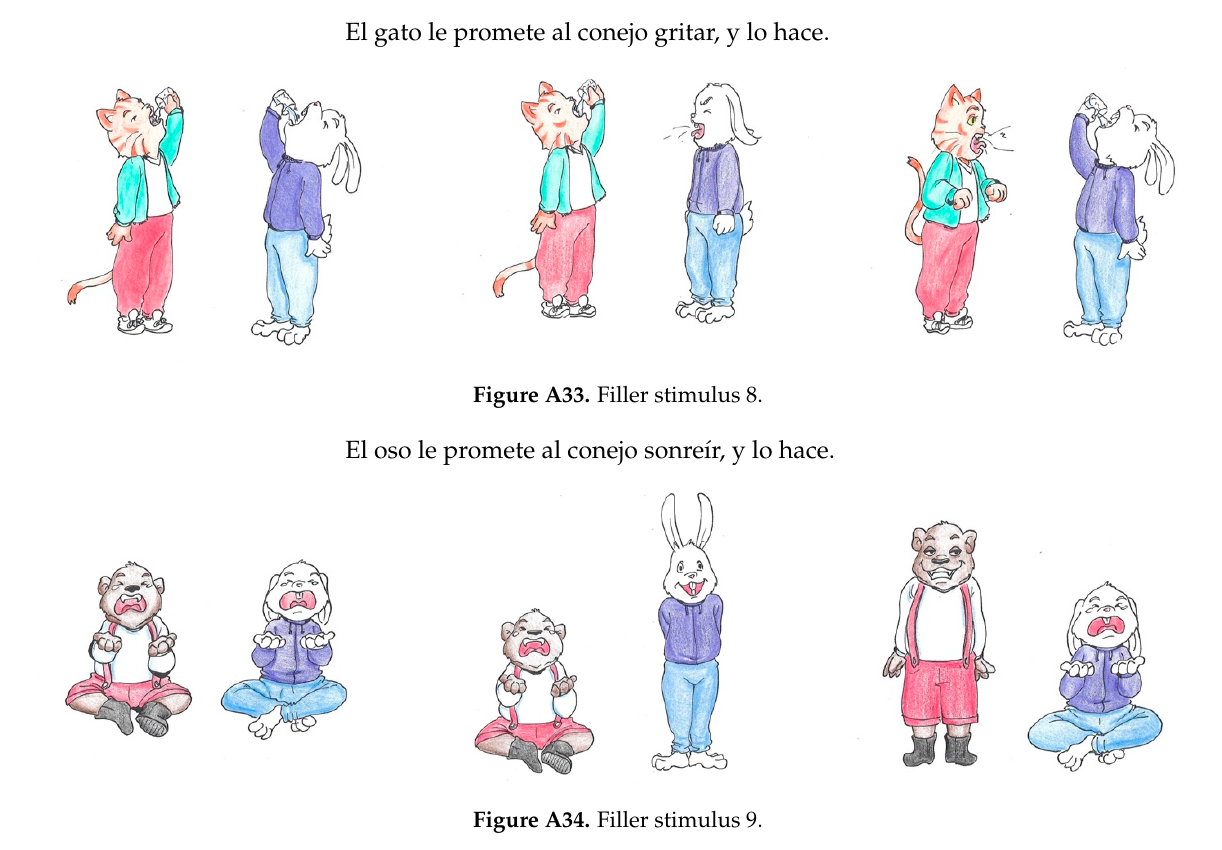
Figure A32. Filler stimulus 7.